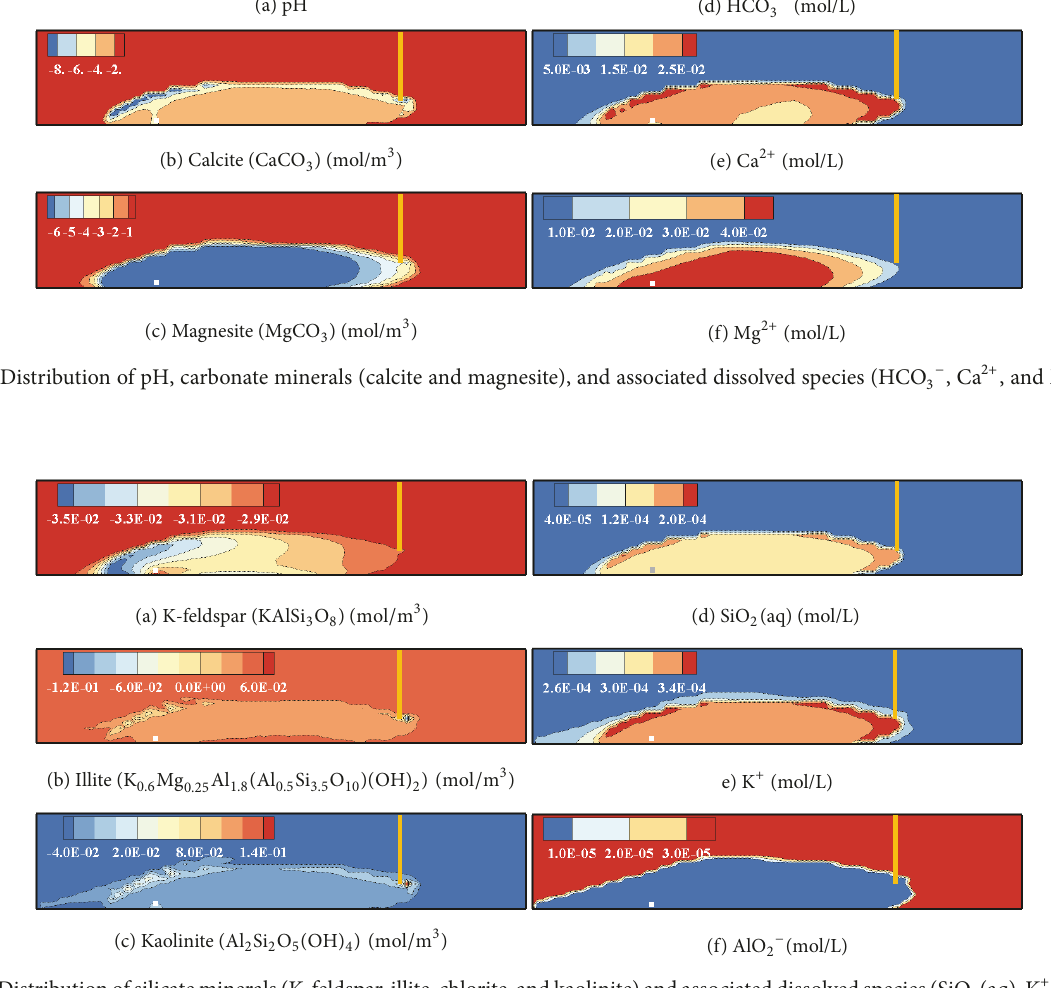
Figure 6: Distribution of silicate minerals (K-feldspar, illite, chlorite, and kaolinite) and associated dissolved species (SiO 2 (aq), K + , and AlO 2 ) after 365